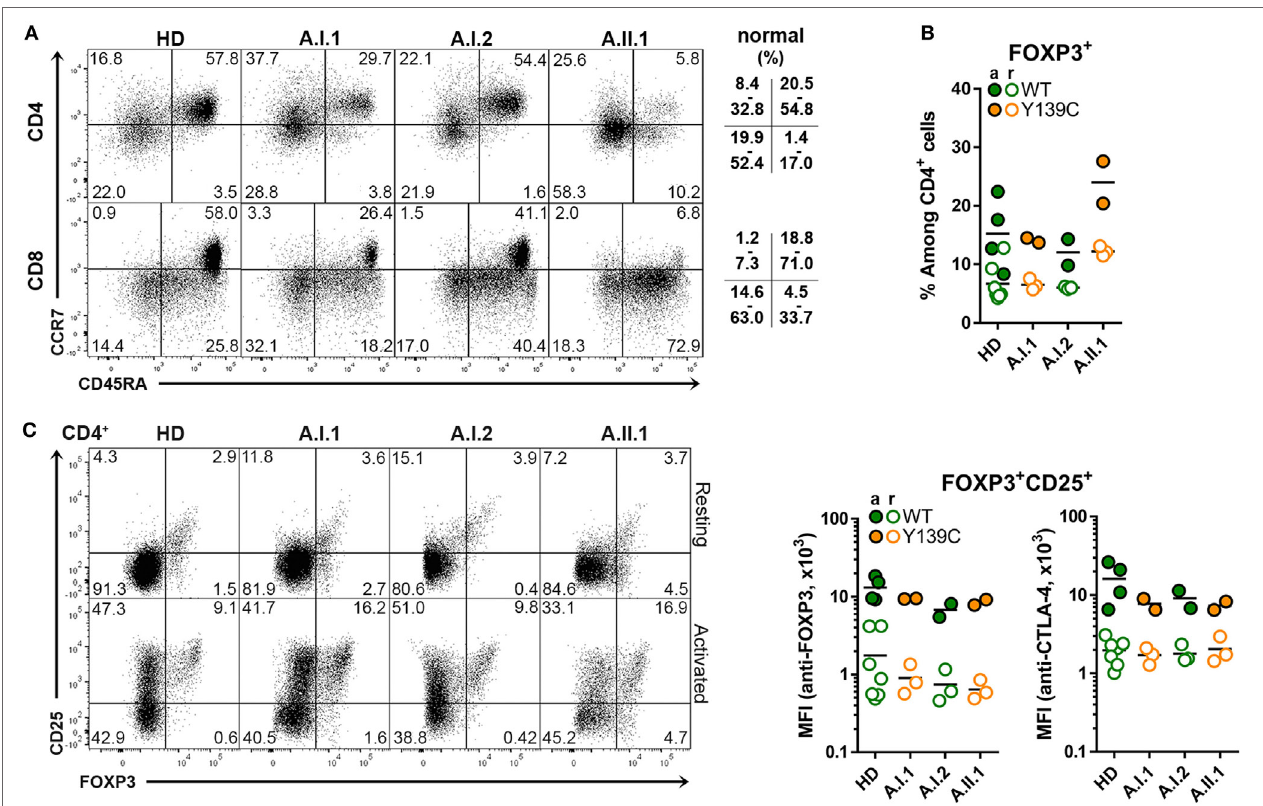
FigUre 2 | Cytotoxic T lymphocyte antigen-4 (CTLA-4) expression in T REG cells. (a) Representative flow cytometry plots of PBMCs stained with anti-CD3, CD4, CD8 CD45RA, and CCR7 antibodies. The plots show the population frequencies of naïve T cells (upper right), central memory T cells (upper left), effector memory T cells (bottom left) and CD45RA + effector memory T cells (bottom right) cells in the CD3 + CD4 + or CD3 + CD8 + T cell subsets isolated from a healthy donors (HD), family members A.I1.1, A.I.2, and patient A.II.1. The normal range of each subset is indicated. (b) Percentage of FOXP3 + CD4 + T REG cells from HD and from family A members A.I.1, A.I.2, A.II.1 (patient). (c) Representative flow cytometry plots showing T REG cells of resting and anti-CD3 + anti-CD28-activated CD4 + T cells stained with anti-CD25 and anti-FOXP3 antibodies. The bar graph displays the mean fluorescence intensity of FOXP3 and of CD25 signals of resting (open circles) and activated (filled circles) CD4 + T cells isolated from HD and family A members A.I.1, A.I.2, and A.II.1 (patient). Horizontal lines represent mean values. The dots in (b,c) represent the samples of individual HD or family member analyzed in replicates in repeated experiments carried out after different